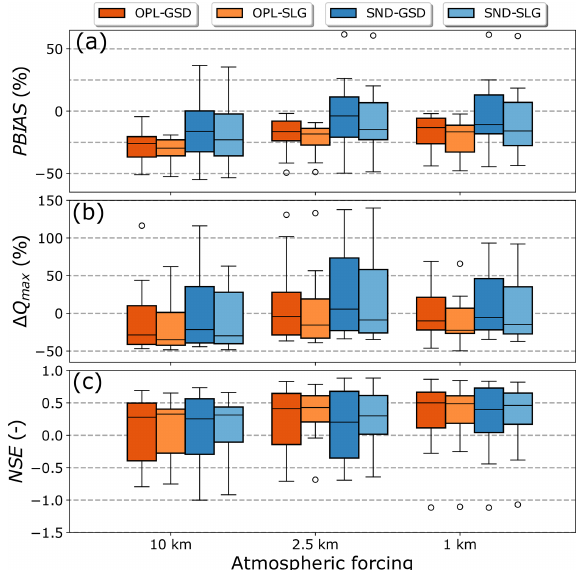
Figure 9. Distributions of error metrics for the different GEM- Hydro simulations of the June 2013 flood as a function of the resolu- tion of the atmospheric forcing: (a) percent bias, (b) relative differ- ence of peak flow amplitude and (c) the Nash–Sutcliffe efficiency. The color of the boxplots depends on the different soil and snow ICs and on the soil texture database. Error metrics were computed from 20 June at 00:00UTC to 25 June at 00:00UTC. Their definition is given in Appendix A.